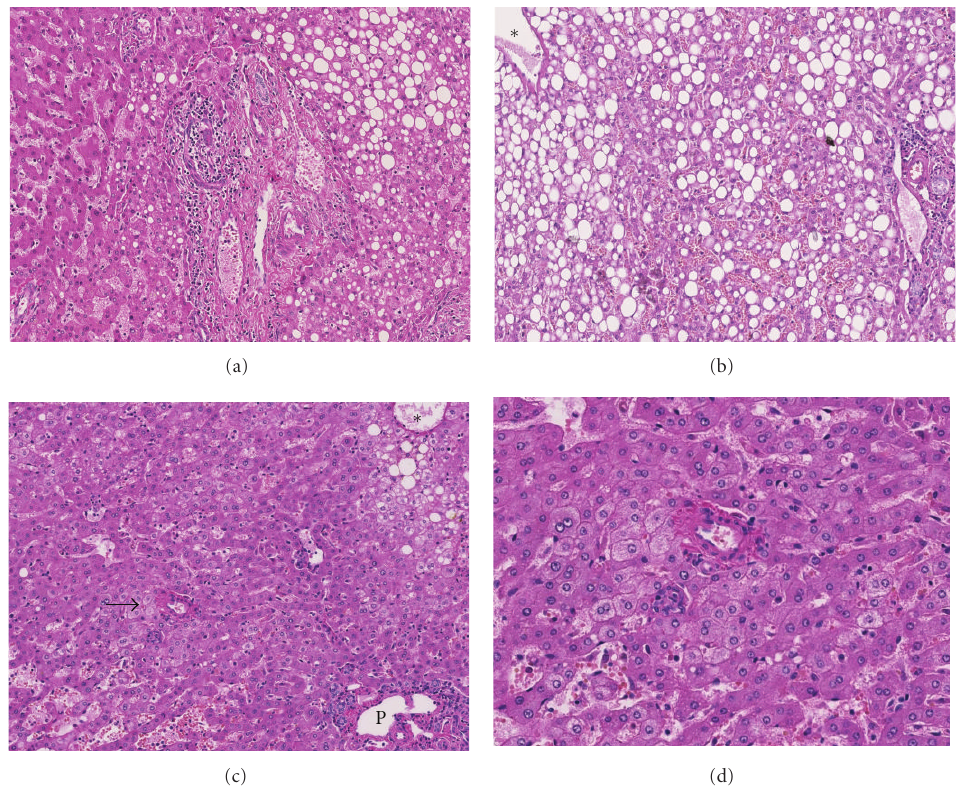
Figure 2: Steatosis and vascular changes. (a) The transitional area of a nonsteatotic adenoma (left part) with a steatotic adjacent nontumorous liver (right part). (b) Moderate steatosis in a distant sample. A portal tract is present in the right lower corner and a central vein in the left upper corner ( ∗ ). (c) Vascular changes in a distant sample. A portal tract (P) is present in the right lower corner and a central vein in the right upper corner ( ∗ ). An area with dilated sinusoids is present in the left lower corner. The arrow indicates a group of single arteries. (d) Detail of the single